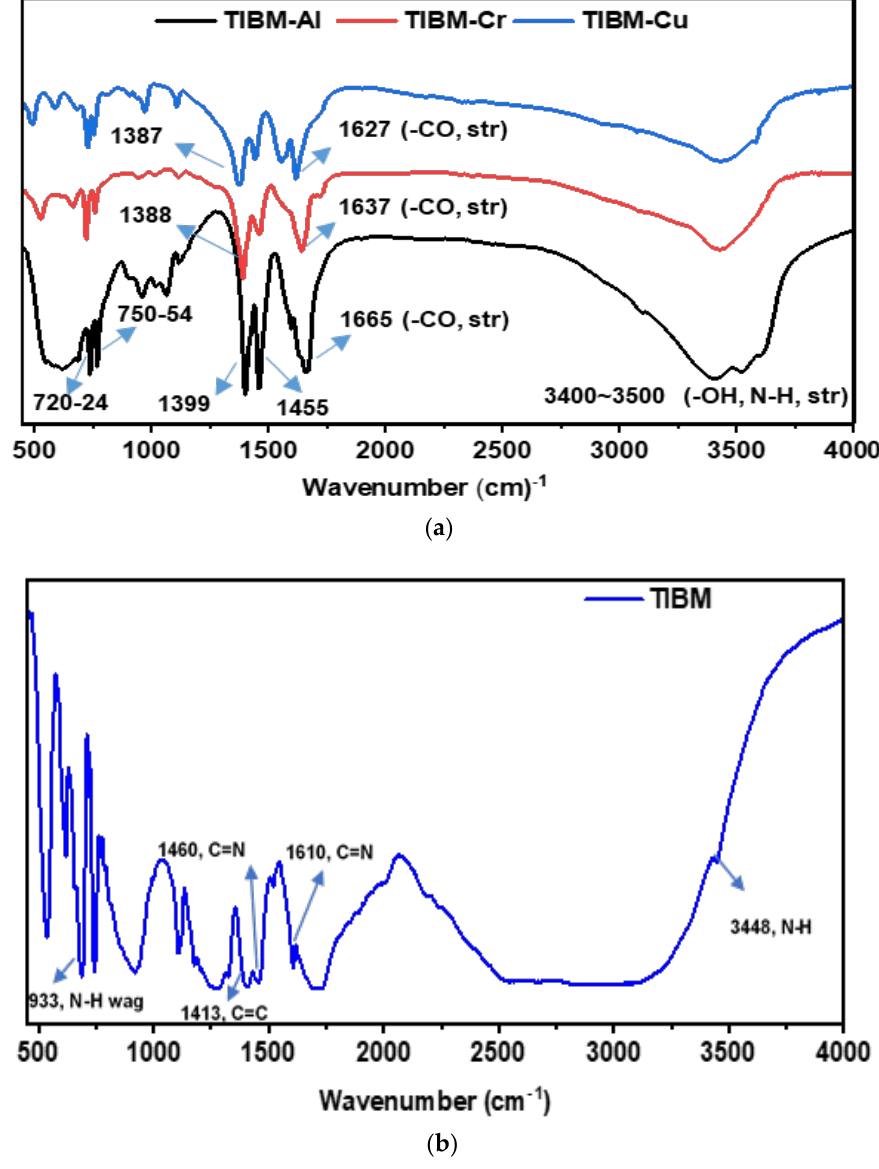
Figure 4. FTIR spectra of ( a ) TIBM − Al, TIBM − Cr, and TIBM − Cu, and ( b ) TIBM.